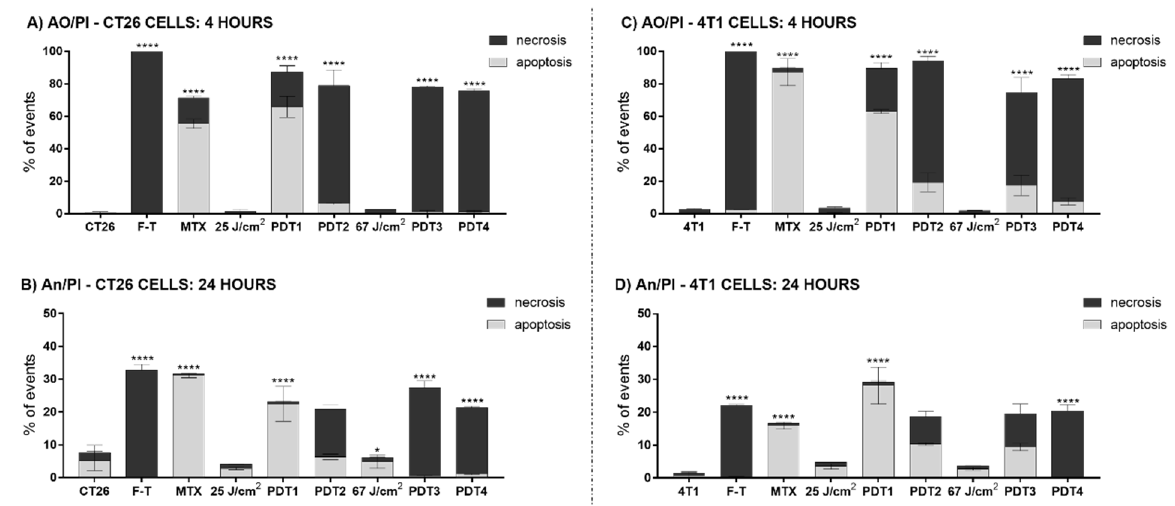
Figure 1. The induction of necrosis and apoptosis by PDT-AlPc-NE is affected by both the concen- tration of photosensitizer and the energy dose. ( A ) CT26 cells analyzed by the AO/PI method after 4 h of treatment; ( B ) CT26 cells analyzed by AnV/PI method after 24 h of treatments; ( C ) 4T1 cells analyzed by the AO/PI method after 4 h of treatment, and ( D ) 4T1 cells analyzed by the AnV/PI method after 24 h of treatments. Light gray bars represent the results of apoptotic cells, and dark gray bars represent necrotic cells. Untreated cells are represented with CT26 and 4T1.PDT protocols for CT26 cells: PDT1 = 12.2 nM and 25 J/cm²; PDT2 = 31.5 nM and 25 J/cm²; PDT3 = 12.2 nM and 67 J/cm²; and PDT4 = 31.5 nM and 67 J/cm².PDT protocols for 4T1 cells: PDT1 = 9.01 nM and 25 J/cm²; PDT2 = 19.4 nM and 25 J/cm²; PDT3 = 9.01 nM and 67 J/cm²; and PDT4 = 19.4 nM and 67 J/cm². MTX: mitoxantrone; F-T: three cycles of freeze-thawing; AO/PI: acridine orange and propidium iodide; AnV/PI: Annexin V and propidium iodide. Superscripts * and **** represent p < 0.05 and p < 0.0001 relatives to apoptotic and necrotic cells of the same group. Data are presented as mean ± SEM for triplicates.